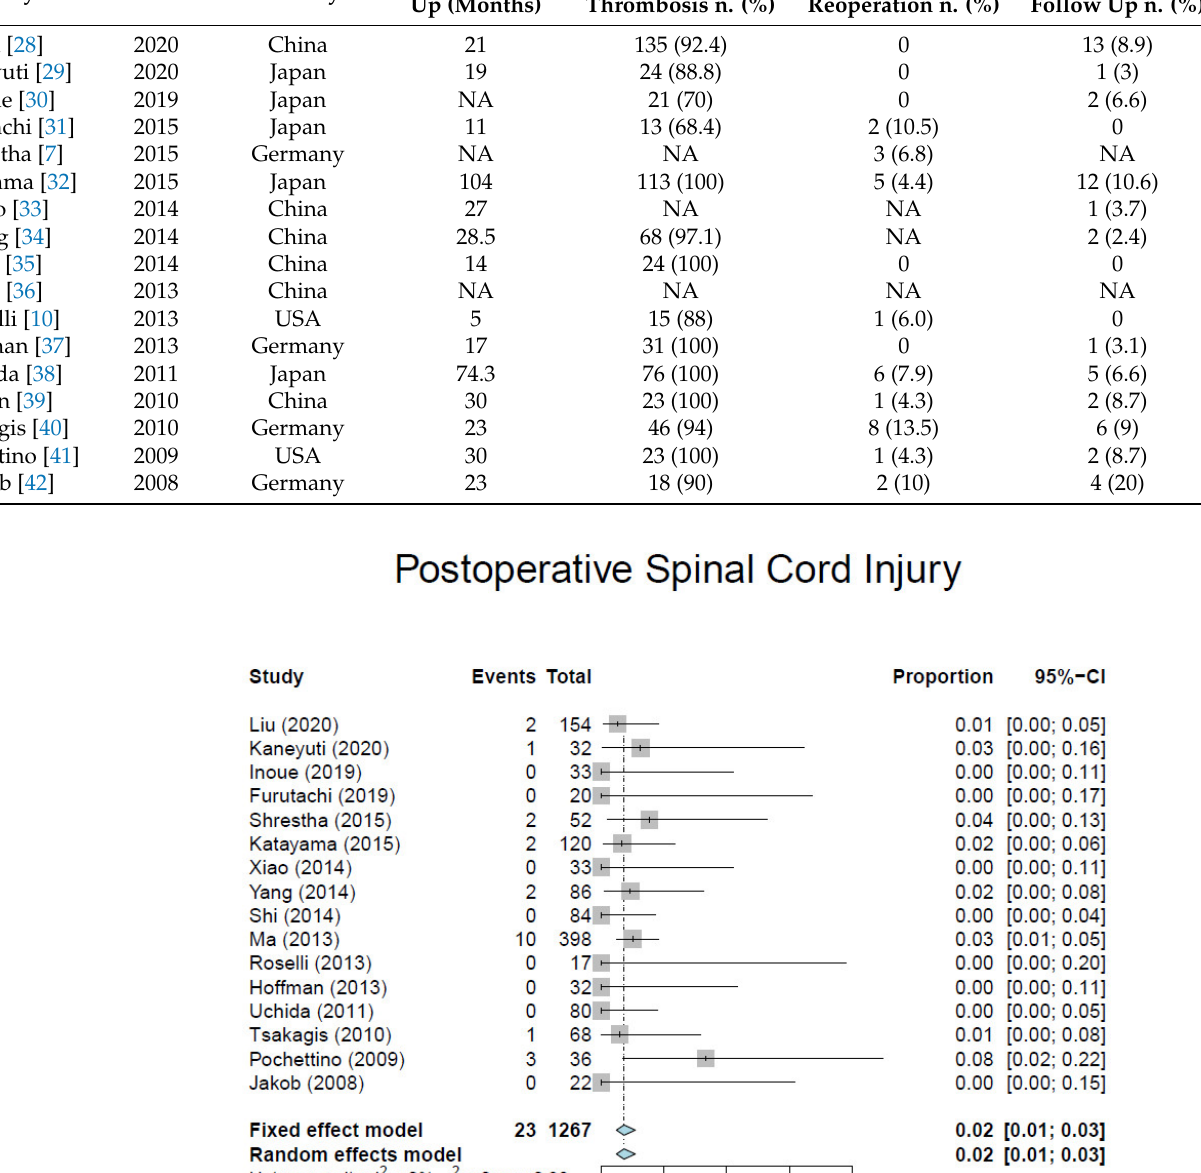
Figure 6. Forest plot depicting pooled estimates of distal aortic re-operation at follow-up.